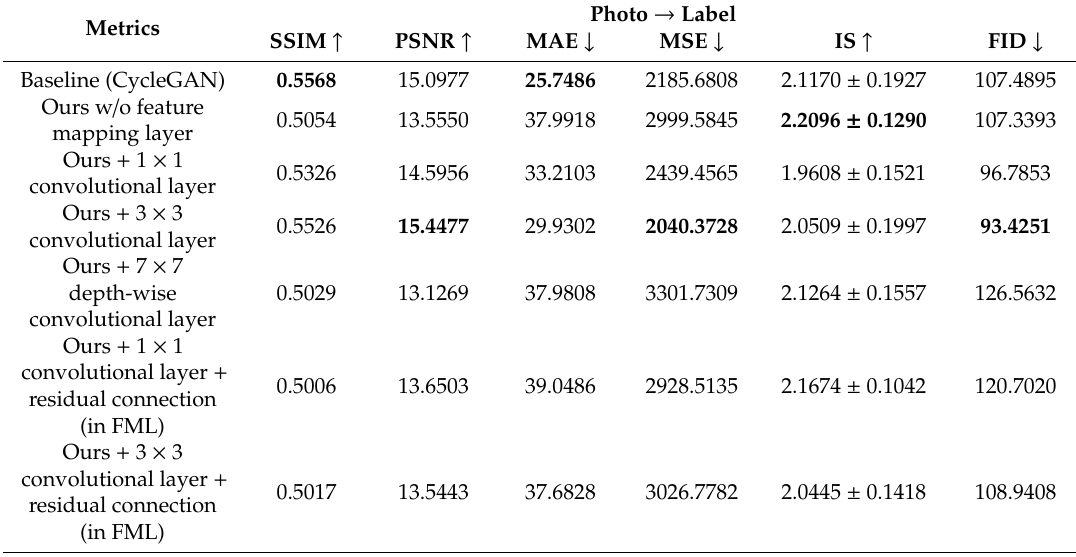
Table 2. Ablation study of our model on cityscapes dataset (photo → label). Higher value is better in SSIM, PSNR, IS. Lower value is better in MAE, MSE,